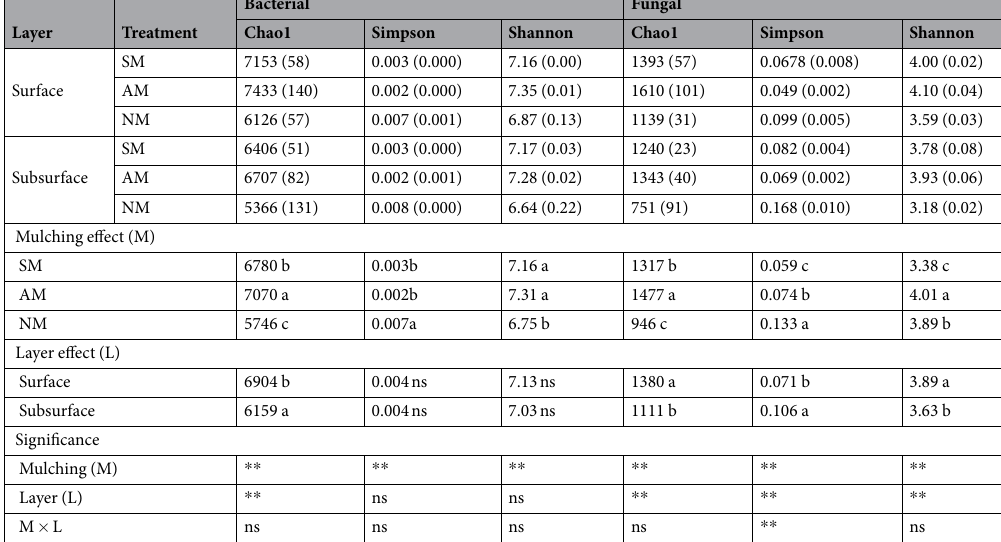
Table 2. Effects of different mulching treatments on bacterial and fungal α -diversity. Values are shown as the means (with standard error in parentheses). The values in mulching effect or layer effect were given the means under each mulching treatment or soil layer. * P < 0.05; ** P < 0.01; ns, not significant.